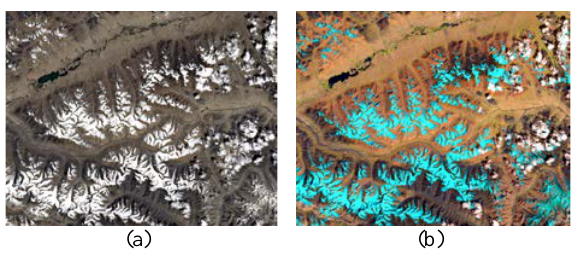
Figure 4. (a) 432-band true color synthesis. (b) 652-band fake color synthesis